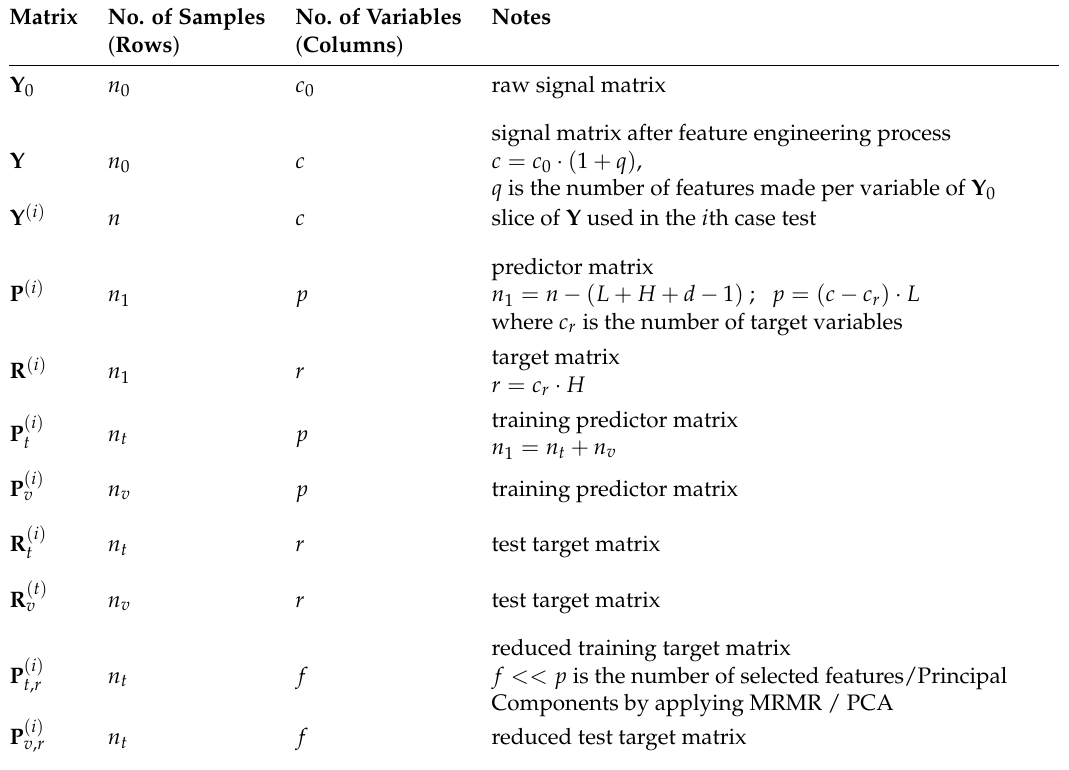
Table 2. Matrix relation in a Supervised Learning strategy for Time Series Forecasting.